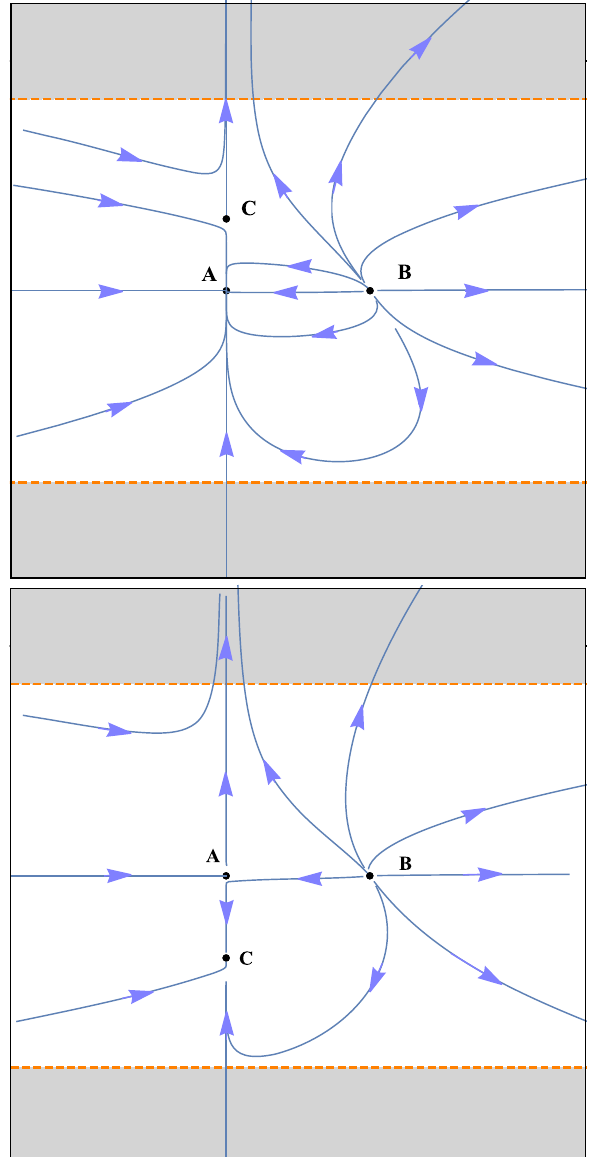
Fig. 2 Stability diagrams of fixed points discussed in Sect. 3.3 (see cases (i) and (iii) there), with − 4 / 3 < w < − 1 at the top ( a ) and − 1 < w < − 2 / 3 at the bottom ( b ). In a the attractor A describes an accelerated, torsionless, flat FRW model filled with phantom matter (see Sect. 4.2 here). Fixed point B is an unstable repulsor representing the Milne solution (e.g. see [18]), while C is an intermediate (transition) saddle point corresponding to an accelerating, spatially flat, FRW-like universe with weak torsion and phantom matter (see Sect. 4.4). In b , on theotherhand,thesaddlepointAisatorsion-freeFriedmanncosmology with zero 3-curvature and dark energy (see Sect. 4.2 before), B is still the Milne repulsor and C is the attractor that represents a flat FRW-like modelwithweaktorsionanddarkenergy.NotethatthefixedpointChas ¯ Ω ¯ Ω φ > 0 in a and φ < 0 in b . Also, in both figures, the shaded regions contain torsional models with | ¯ Ω φ | > 1, lying beyond the boundaries of our “weak-torsion”